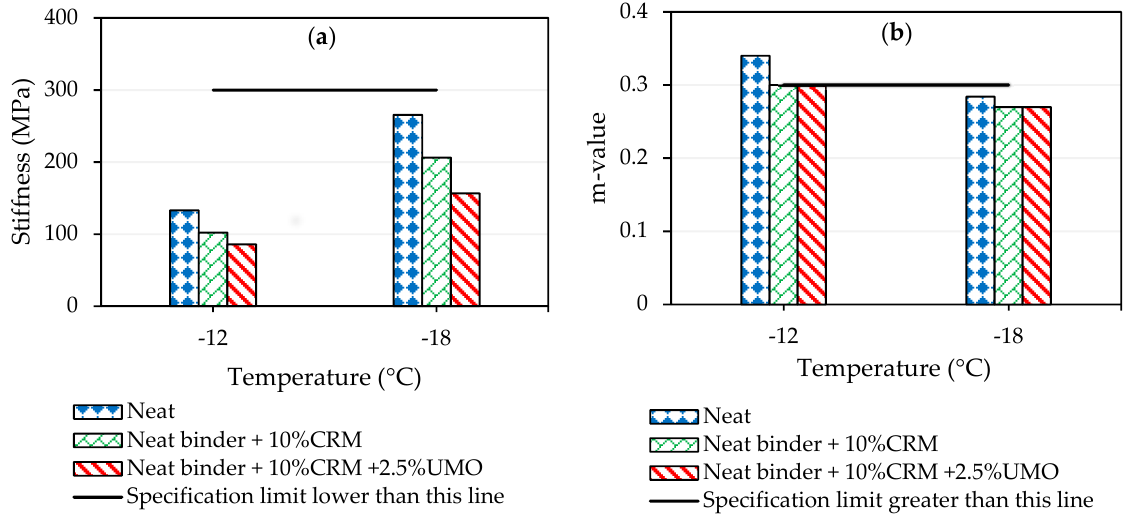
Figure 5. BBR test results: ( a ) BBR stiffness; ( b ) BBR m-value, measured for PG 64-22 neat and modified asphalt binder samples interacted at 190 °C—50 Hz—62 min.